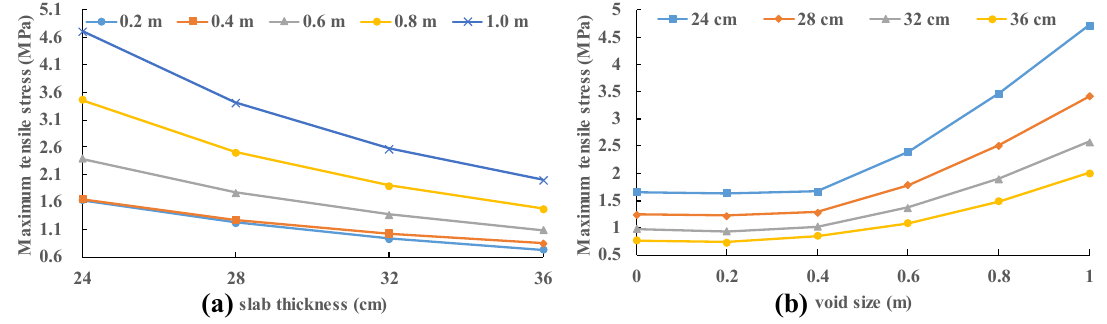
Figure 11. Variation in stress of the slab with slab thickness and void size: ( a ) slab thickness; and ( b ) void size.